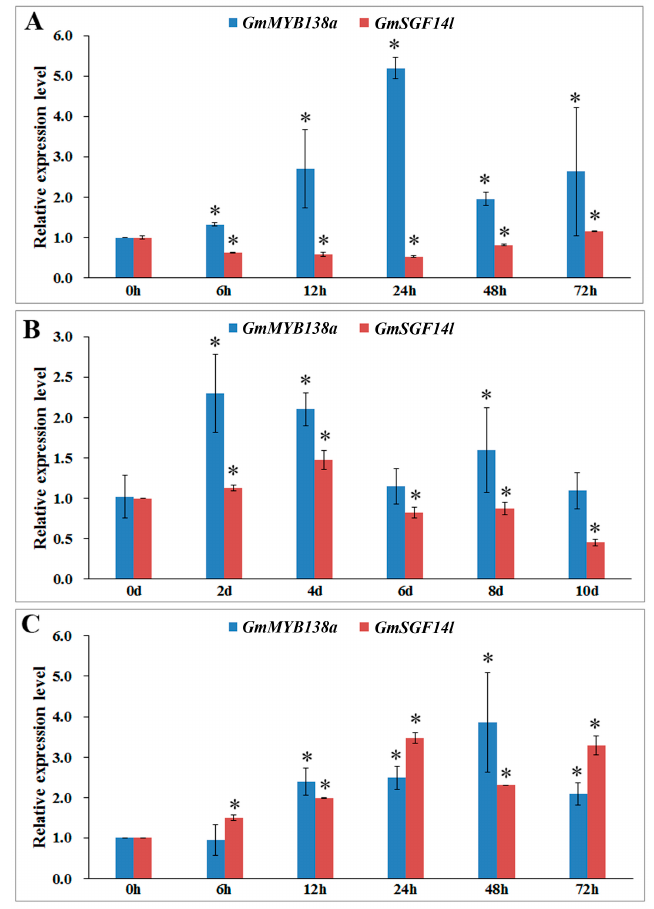
Figure 8. Expression analysis of GmMYB138a and GmSGF14l in response to abiotic stresses. Ten-day-old soybean seedlings were exposed to stress treatment as indicated below. Gene expression analysis was conducted by qRT-PCR using gene specific primers. ( A ) Gene expression pattern of GmMYB138a and GmSGF14l in seedlings exposed to cold stress for 0, 6, 12, 24, 48 and 72 h; ( B ) Gene expression pattern of GmMYB138a and GmSGF14l in seedlings exposed to drought stress for 0, 2, 4, 6, 8 and 10 days; ( C ) Gene expression pattern of GmMYB138a and GmSGF14l in seedlings exposed to salinity stress for 0, 6, 12, 24, 48 and 72 h. Error bars indicate SE (Standard error) of two biological and three technical replicates. Values were normalized against SUBI-3 . Significant differences are denoted by asterisks ( p < 0.01).